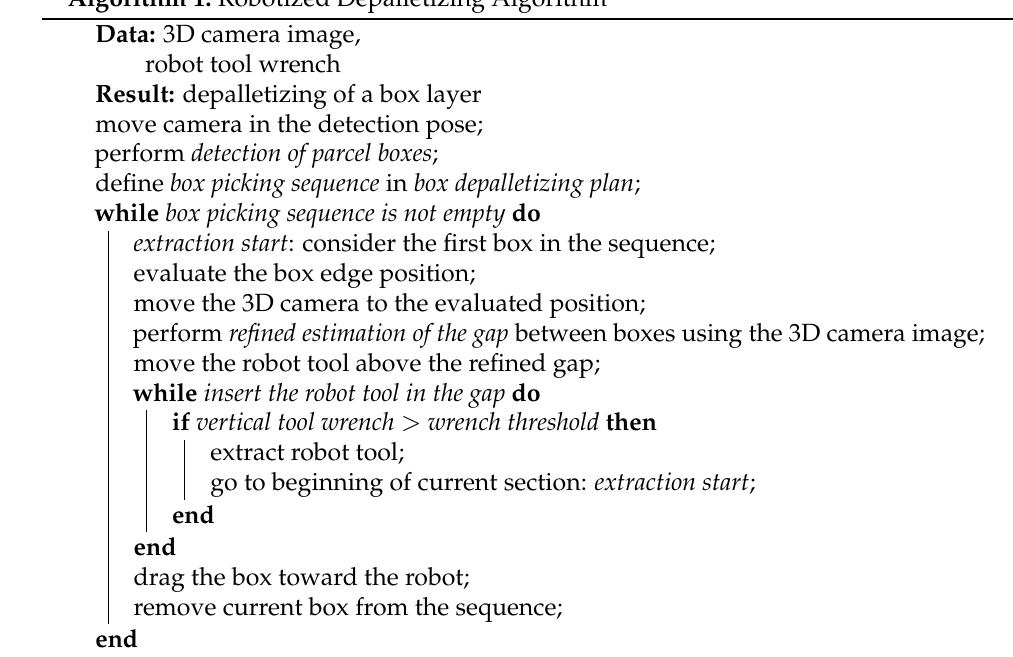
Algorithm 1: Robotized Depalletizing